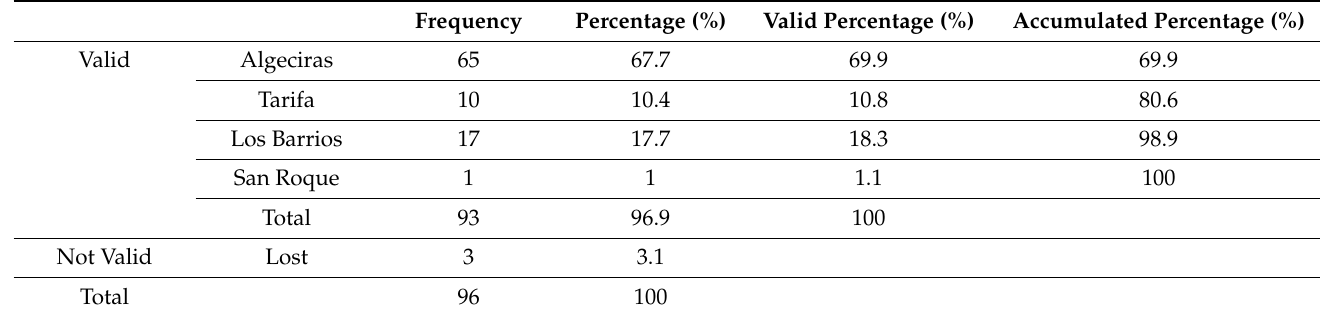
Table 3. Includes the place of residence of the patients studied.